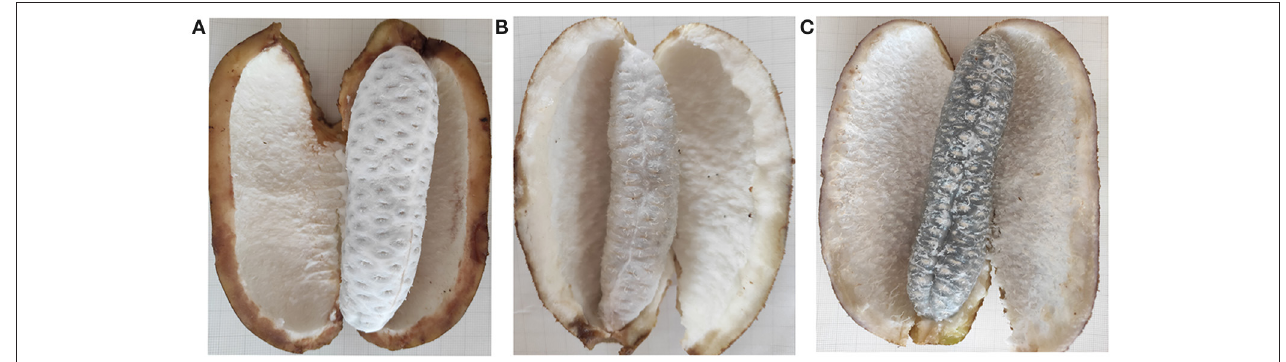
FIGURE 1 | The morphology changes of “Nong No. 8” flesh at different development stages. (A) The morphology of the A. trifoliata flesh at unripe stage without fruit softening (UR). (B) The A. trifoliata flesh remains in hard status but the pericarp begins to crack longitudinally along with its ventral suture (HR). (C) The A. trifoliata flesh is fully matured, soft and edible, accompanied by complete cracking of the pericarp